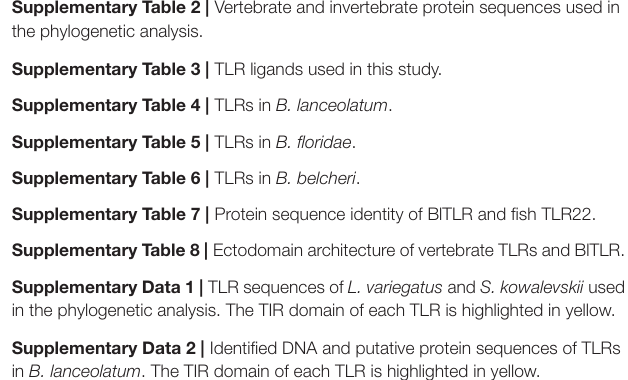
Supplementary Figure 1 | Phylogenetic analysis of B. floridae , B. belcheri and B. lanceolatum TLRs. The phylogenetic tree was constructed by